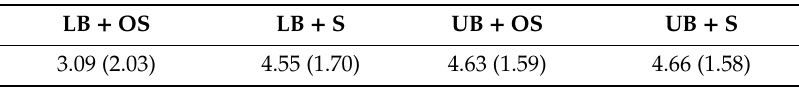
Table 1. Mean of acceptability by condition (SD in parenthesis).